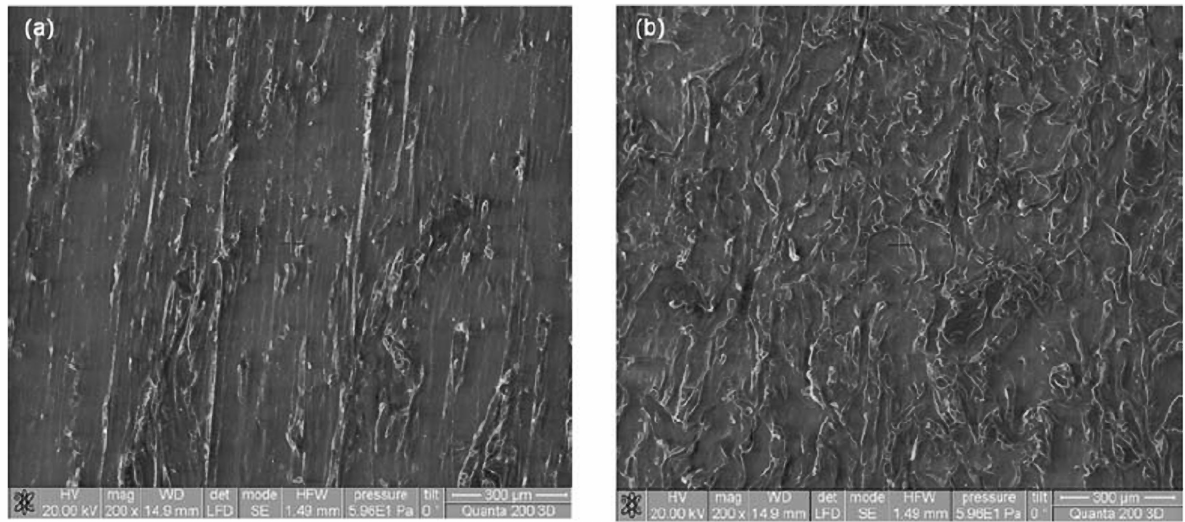
Figure 1. SEM images of “liquid wood”: ( a ) initial sample, ( b ) fractured sample